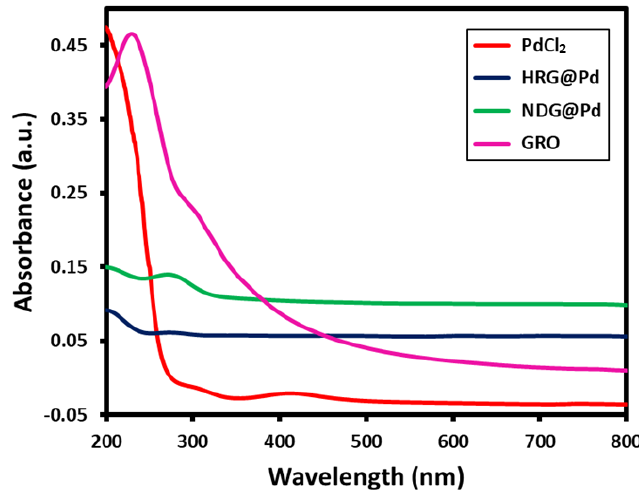
Figure 1. UV‐Vis absorption spectra of palladium chloride (red line), graphene oxide (GRO) (pink line), the highly reduced graphene-based palladium nanocatalysts (HRG@Pd) (blue line), and